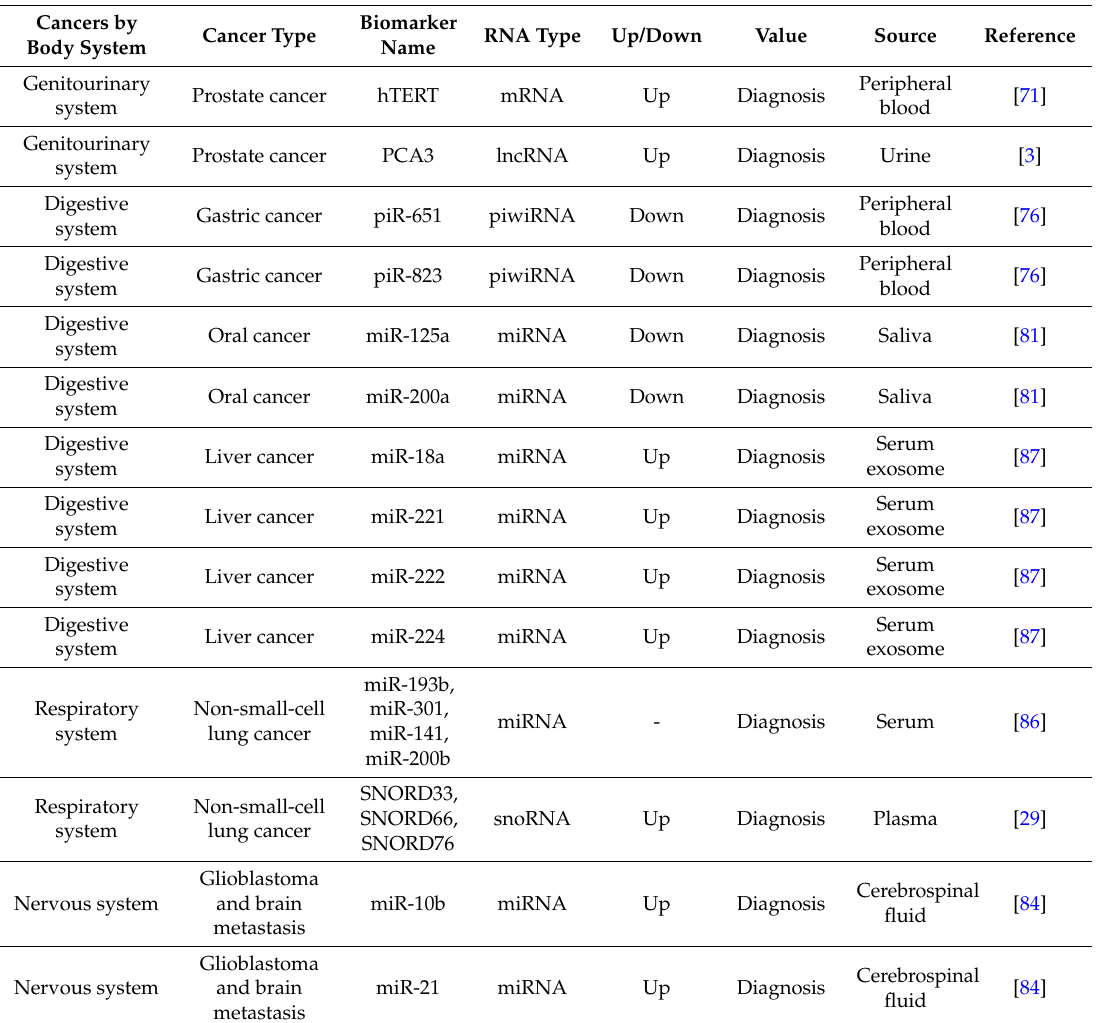
Table 3. Cancer extracellular RNA (exRNA)